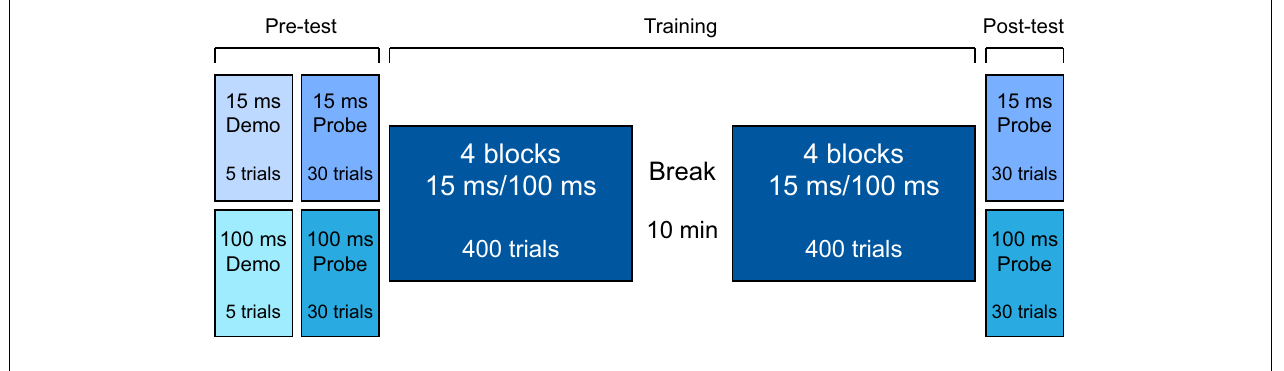
FIGURE 1 | Experimental